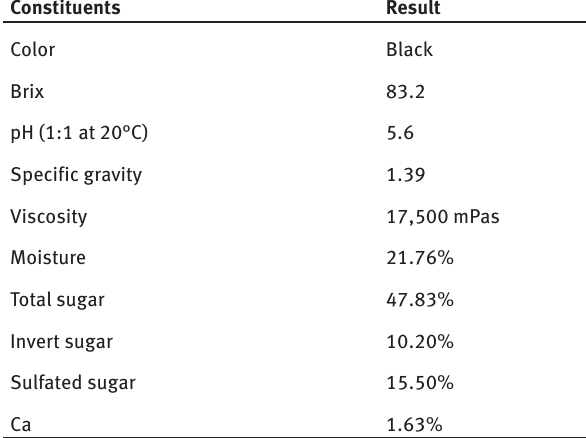
Table 2: Geotechnical properties of clayey soil.